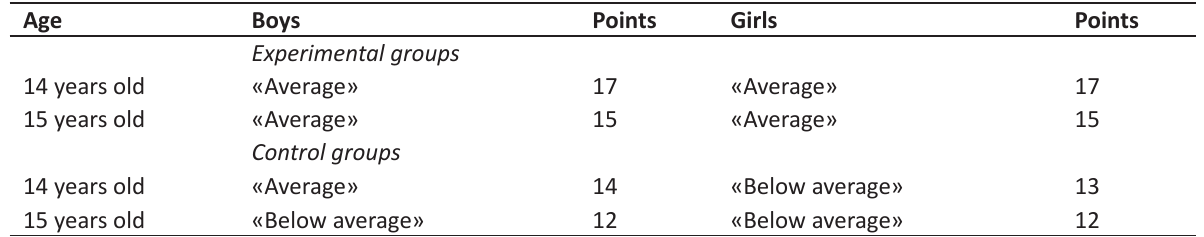
Table 4. Assessment of physical health of schoolchildren aged 14-15 years after the experiment